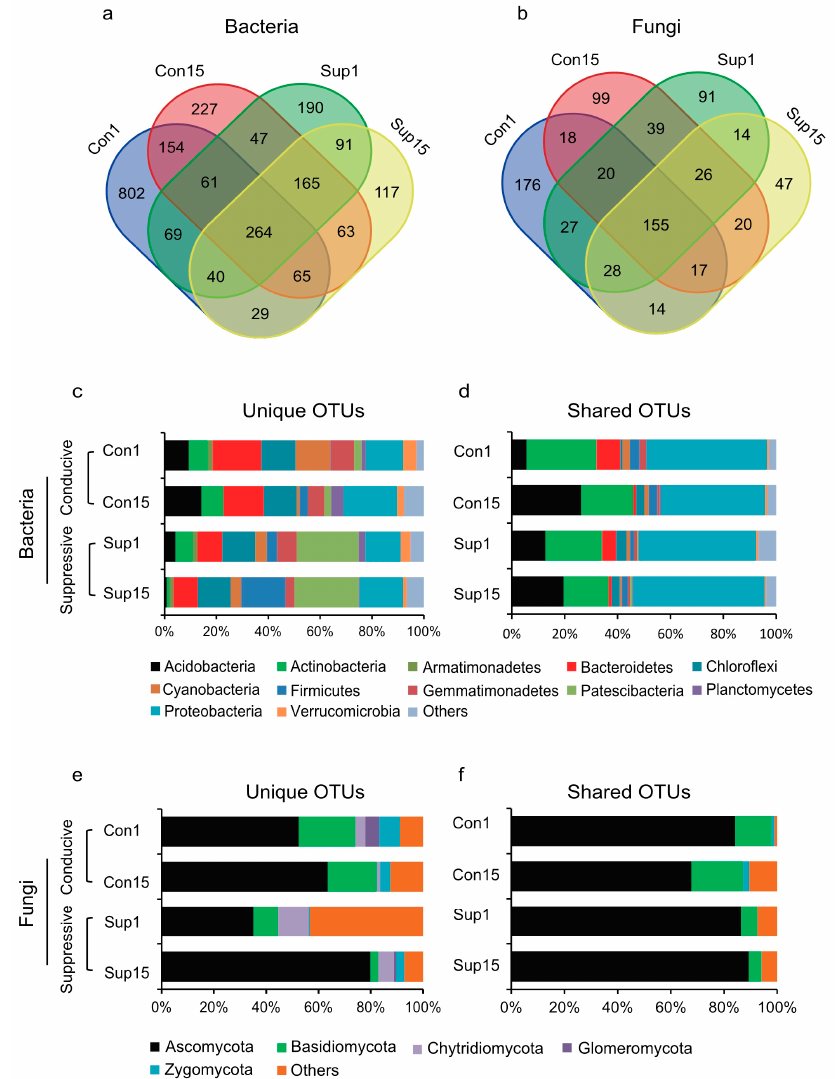
Figure 3. Shared and unique OTUs in both the conducive and suppressive soils under 1- or 15-year monoculture systems. Only the OTUs present in the triplicates of each soil sample were included. Venn diagram showing the number of shared and unique OTUs in the bacterial ( a ) and fungal ( b ) communities. Relative abundance of bacterial ( c , d ) and fungal ( e , f ) phyla in the unique and shared OTUs, respectively.